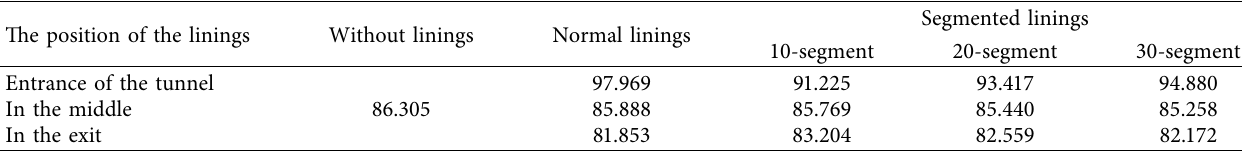
Figure 9: Comparison of the micropressure wave at M 3. (a) Normal linings. (b) 10-segment linings. (c) 20-segment linings. (d) 30-segment linings. Table 4: Te amplitude values of the micro-pressure wave at M 1.